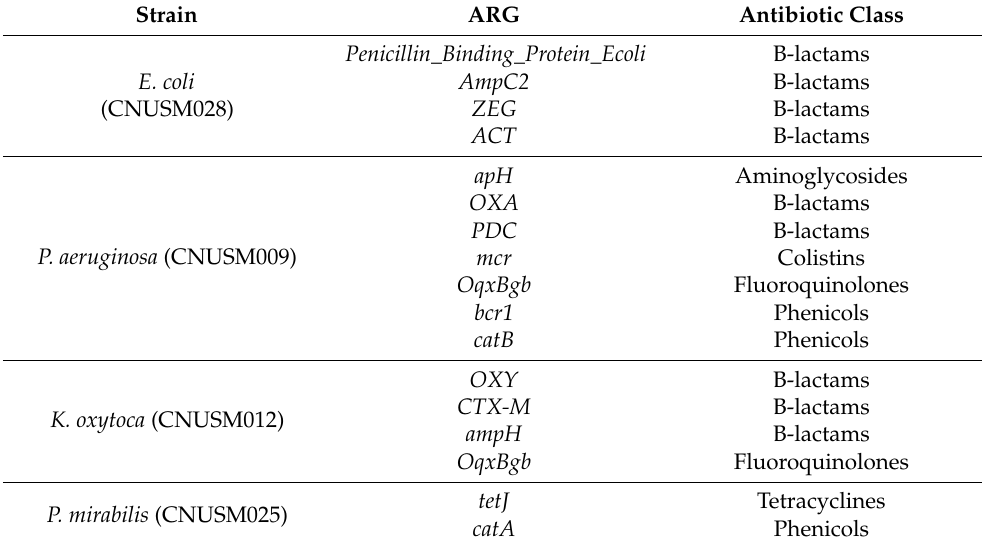
Table 2. ARG annotation of the selected